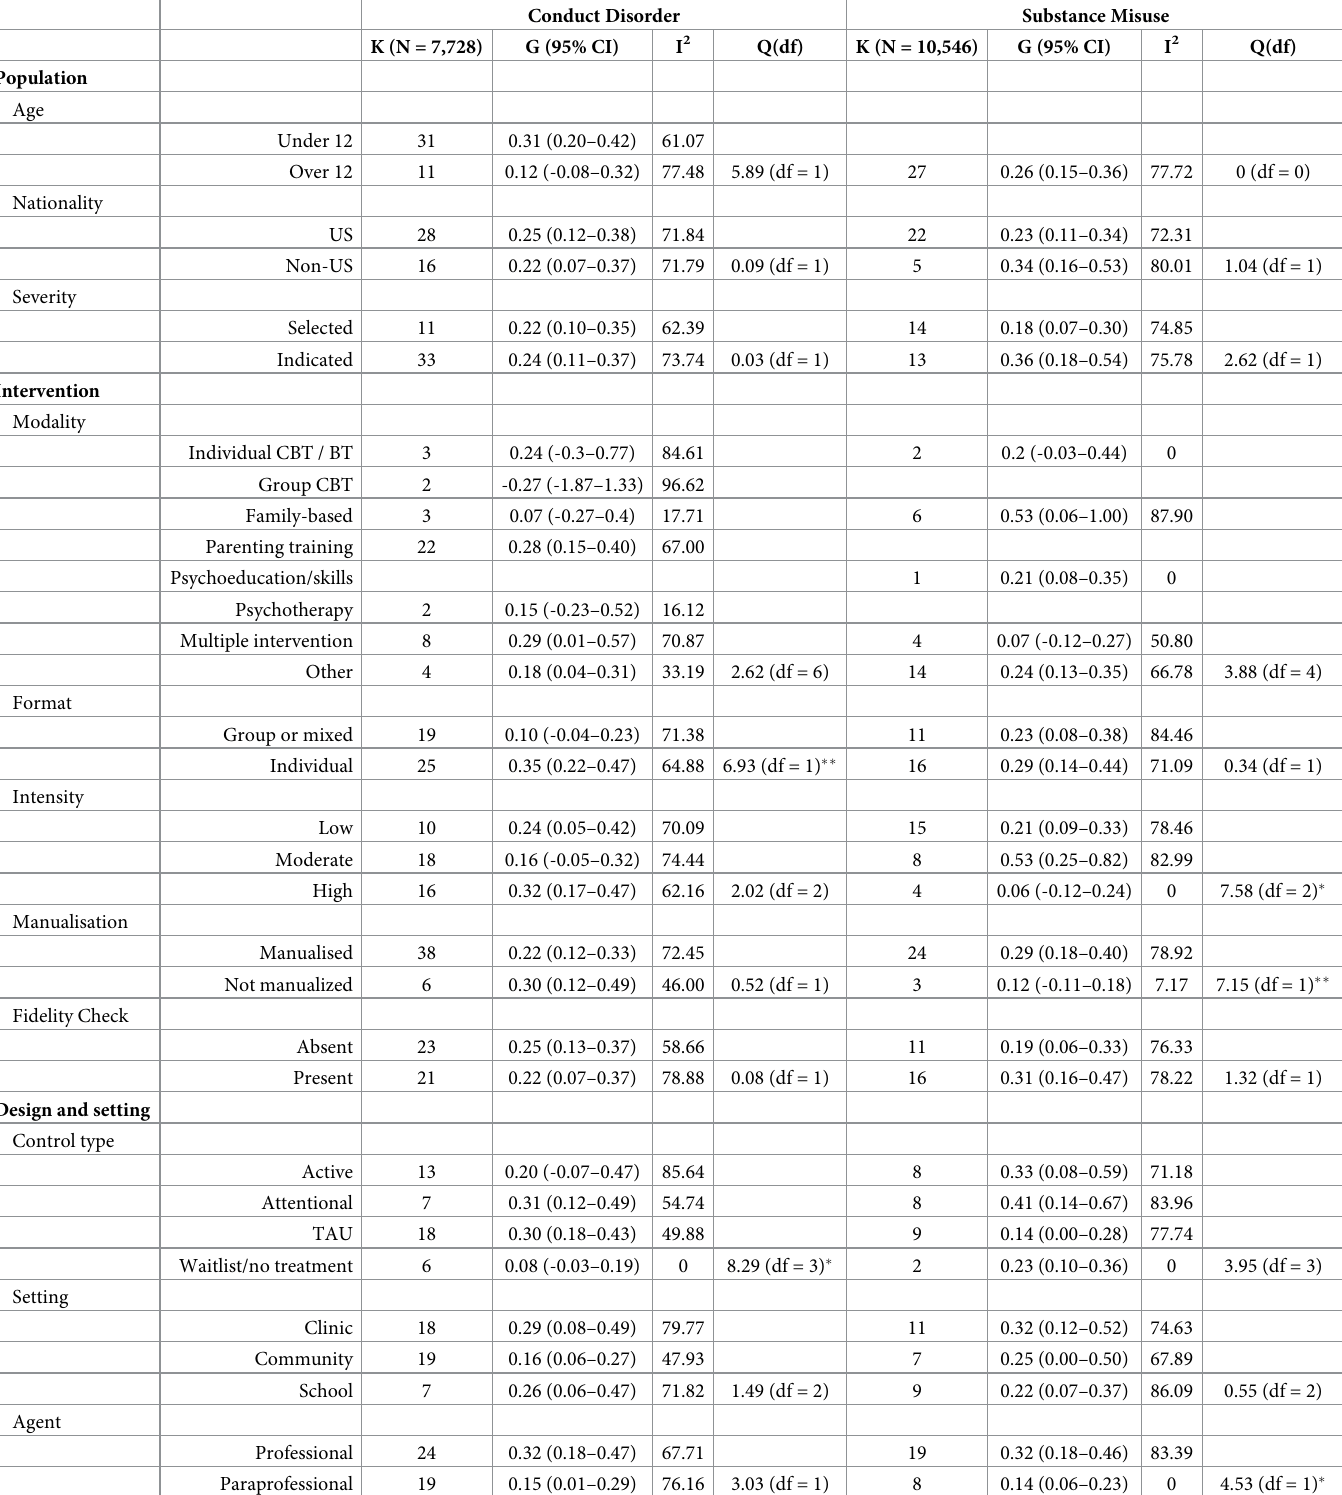
Table 3. Subgroup analysis at follow-up for conduct and substance